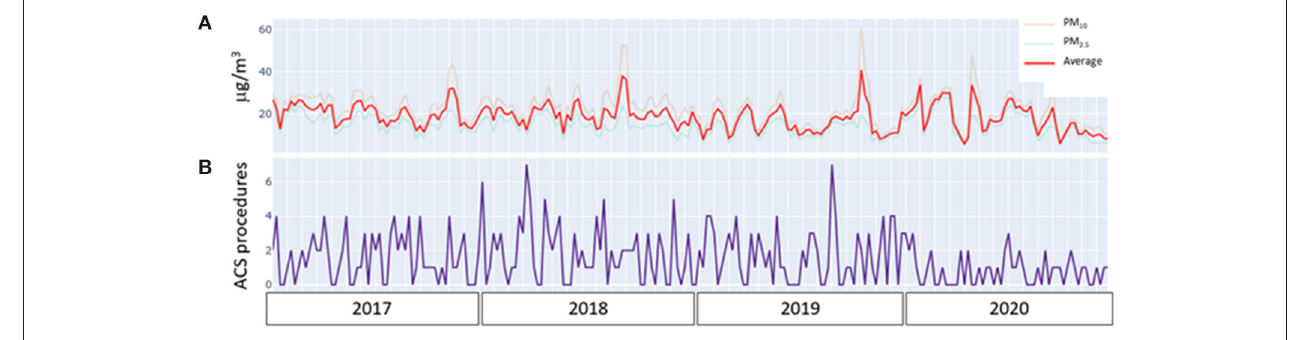
FIGURE 3 | (A) Time/counts analysis plot of time series of air concentration of particulate matter (PM) 2.5 (blue), PM 10 (pink) air pollutants, and their average (red), in the examined periods from 2017 to 2020. (B) Time/counts analysis plot of time series of the number of invasive procedures for acute coronary syndromes (ACS procedures) in the examined periods from 2017 to 2020. The visual inspection of the graph excludes any at-a-glance similarity in slopes of the time series by